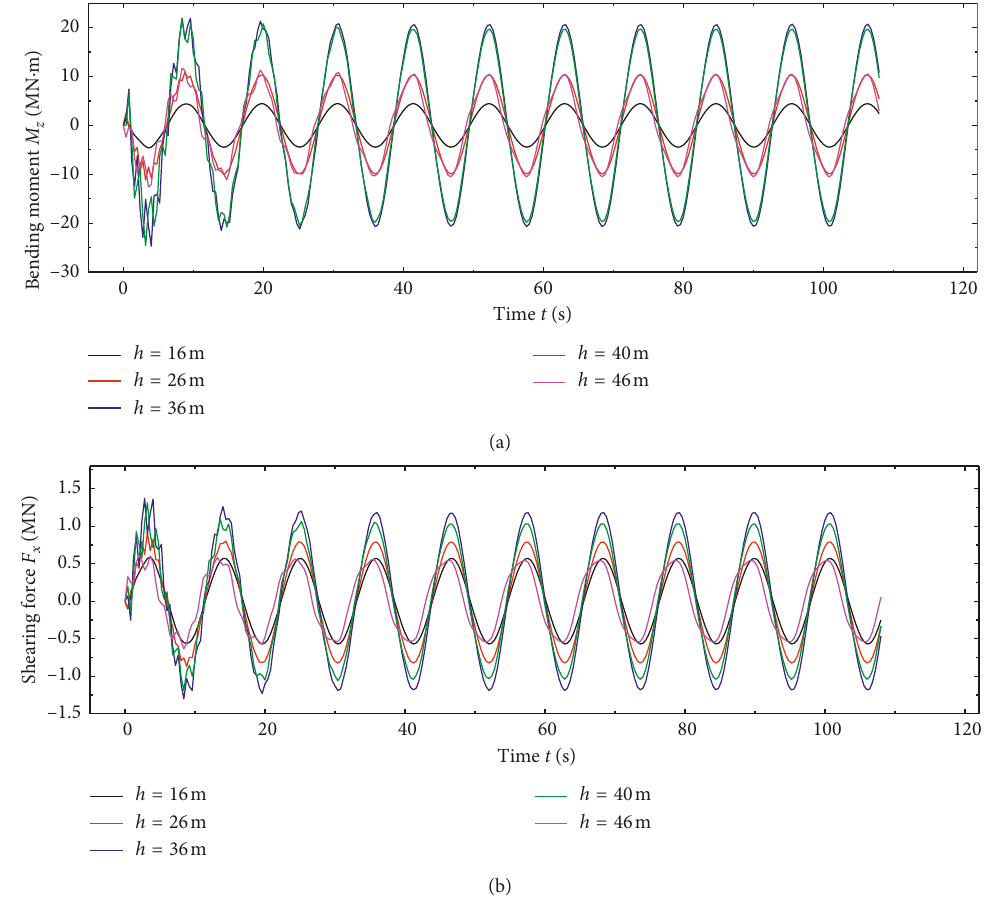
Figure 10: Internal forces of the five foundations. (a) Bending moment. (b) Shearing